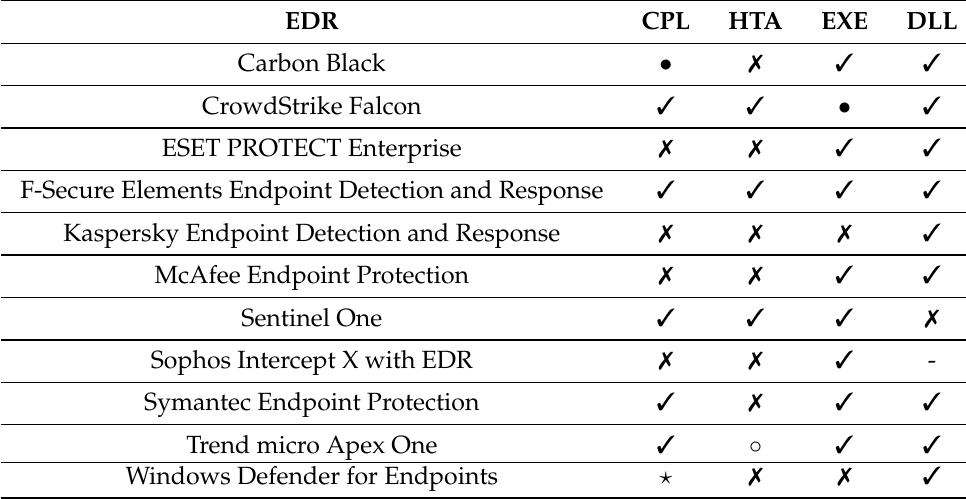
Table 1. Aggregated results of the attacks for each EDR. Notation: (cid:51) : Successful attack, • : Successful attack, raised minor alert, (cid:63) : Successful attack, alert was raised ◦ :Unsuccessful attack, no alert raised, (cid:55) : failed attack, alerts were raised. EDR CPL HTA EXE